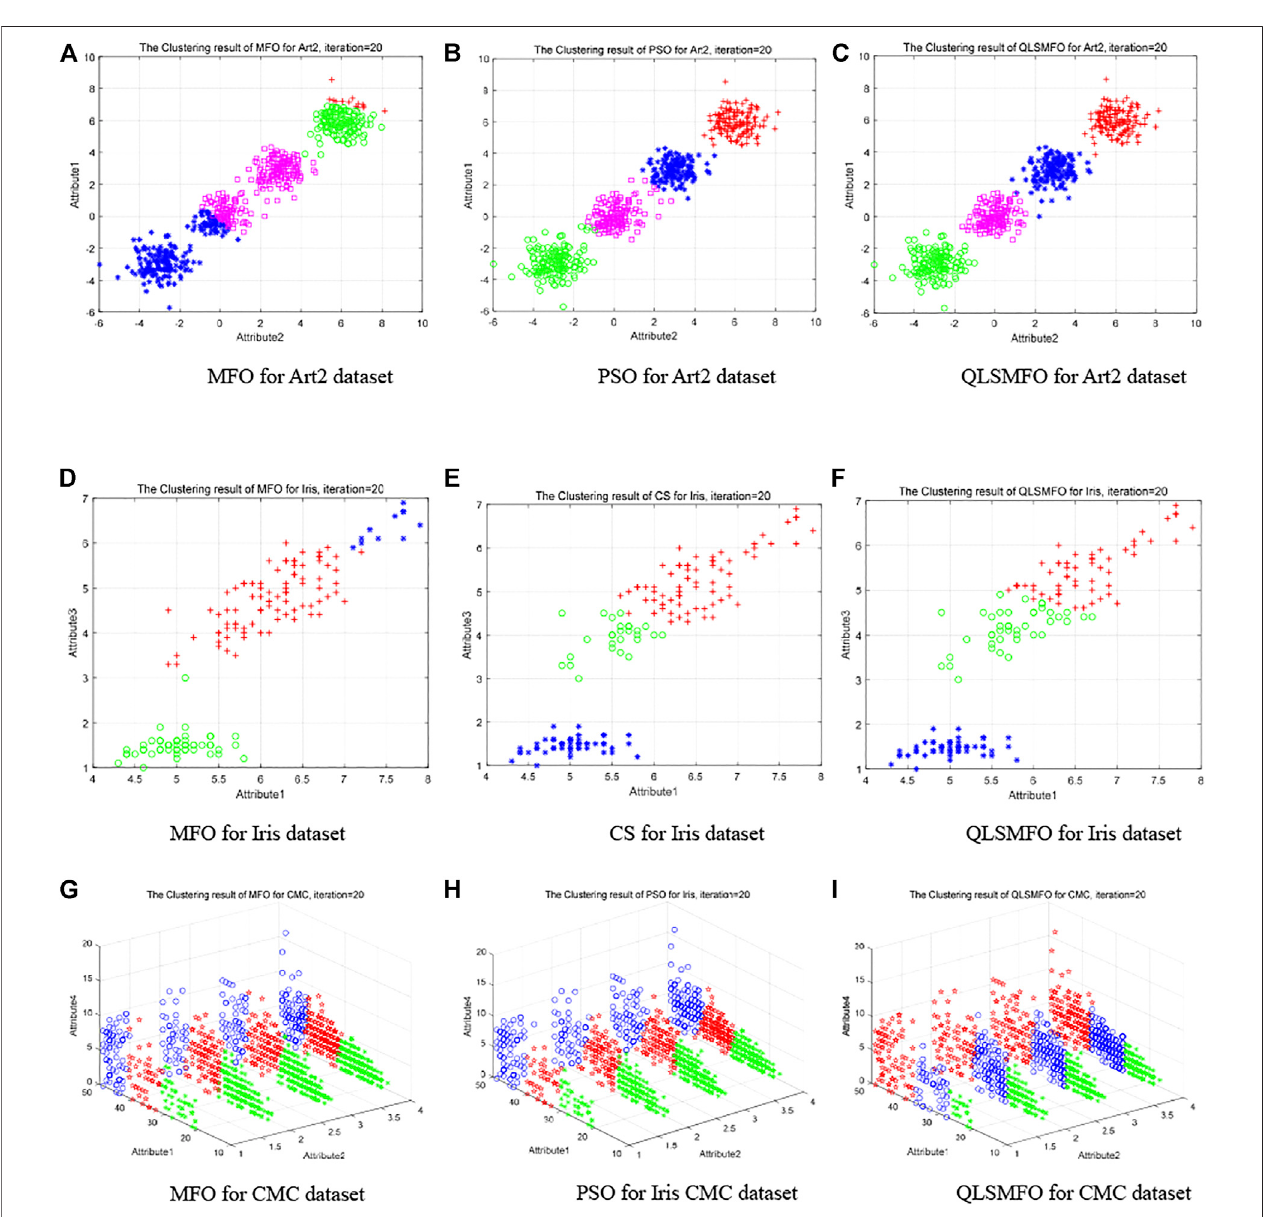
FIGURE 9 | Clustering results of QLSMFO and other algorithms on different datasets at iteration 20. (A) MFO for Art 2 dataset. (B) PSO for Art 2 dataset. (C) QLSMFO for Art 2 dataset. (D) MFO for Iris dataset. (E) CS for Iris dataset. (F) QLSMFO for Iris dataset. (G) MFO for CMC dataset. (H) PSO for Iris CMC dataset. (I) QLSMFO for CMC